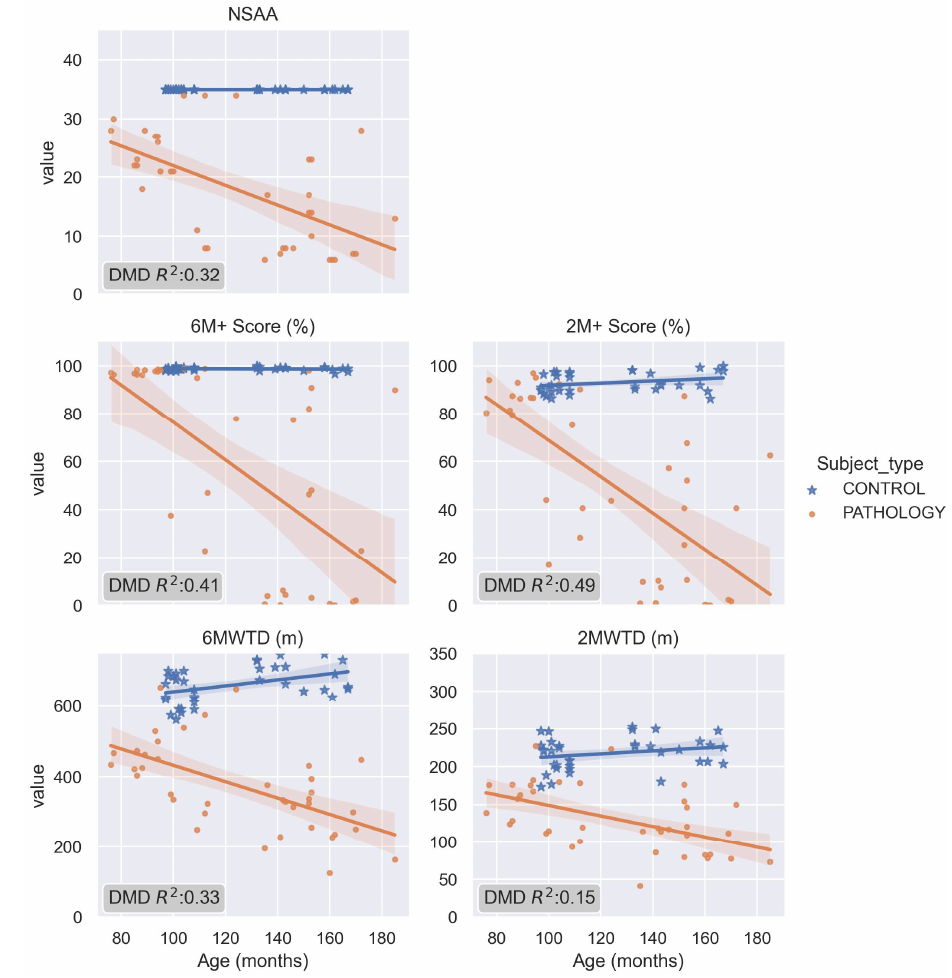
Figure 9. Regression of the target variables from each score methodology with age.